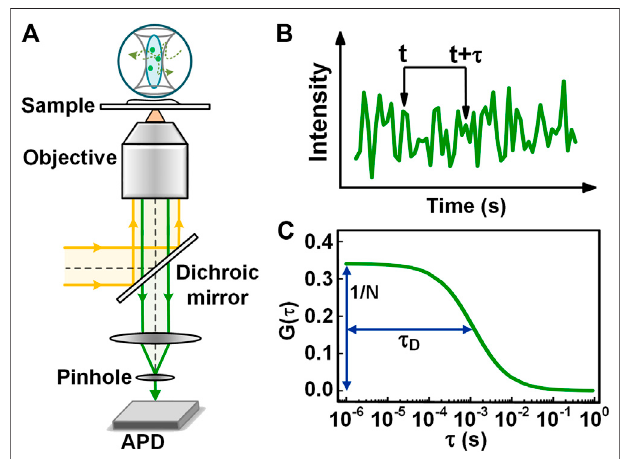
FIGURE 1 | Principle, instrumentation, and data analysis of FCS. ( A ) Schematic view of a confocal based FCS setup. ( B ) The intensity trace collected from the observation volume. ( C ) The autocorrelation curve calculated with the intensity trace in Figure 1B .